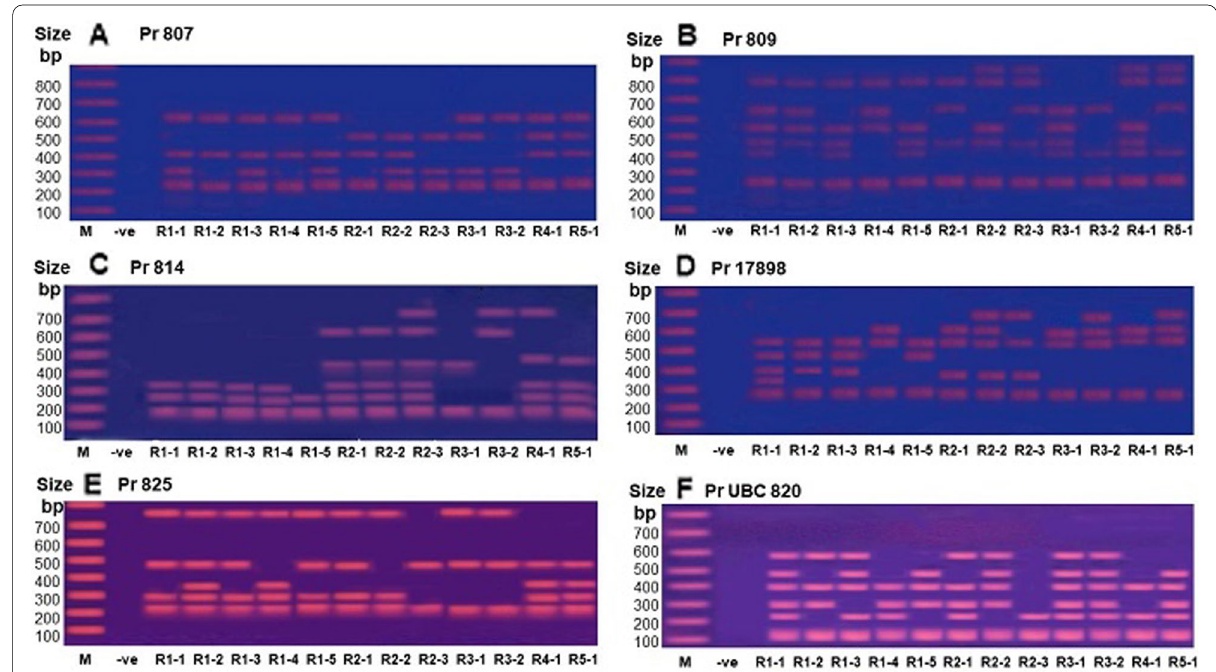
Fig. 1 Photographs illustrating the ISSR fingerprinting of the 12 regenerated genotypes of A. fragrantissima , induced by the six primers. A pr 807, B pr 809, C pr 814, D pr. 17898, E pr 825, and F pr UPC